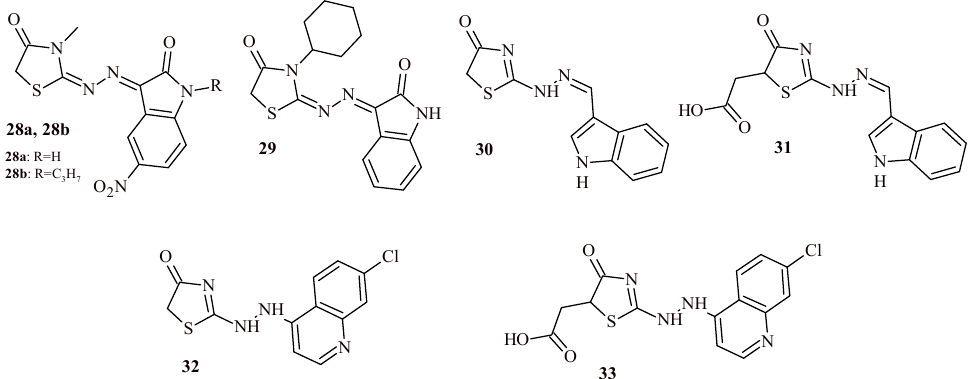
Figure 15. The structures thiazolidin-4-one-based indole and quinoline hybrids. Table 3. Effects of Compounds 28a and 28b on the expression of CDK1, p53, caspase-3 and caspase-9. IC 50 , µM ± S.E. Compound CDK1 p53 Caspase-3 Caspase-9 28a 1.13 ± 0.08 1.07 ± 0.33 1.19 ± 0.32 28b 0.38 ± 0.04 3.04 ± 0.22 5.60 ± 0.49 3.65 ± 0.47 doxorubicin 0.42 ± 0.07 2.36 ± 0.25 3.41 ± 0.25 4.17 ± 0.60